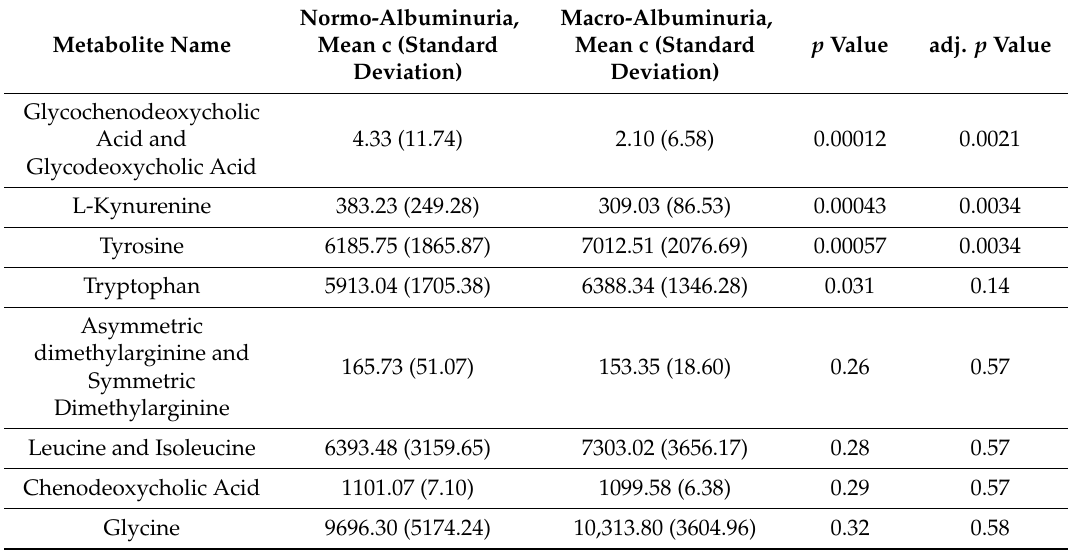
Table 4. Concentrations of metabolites in the validation cohort and their p